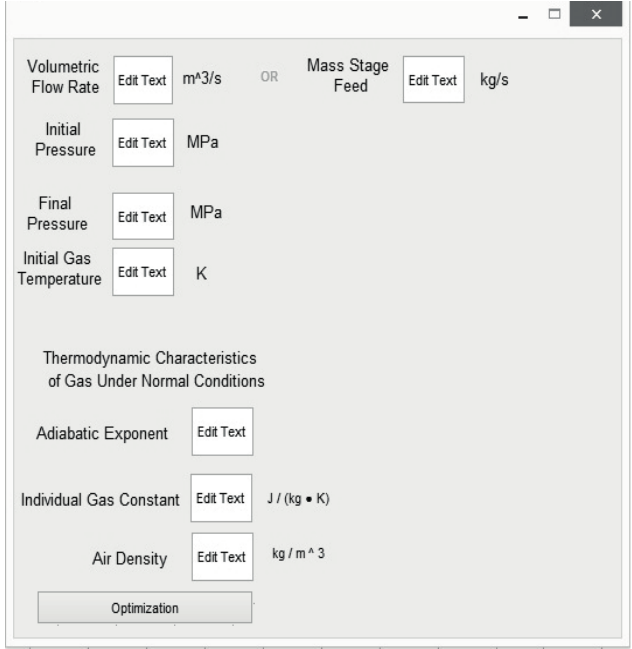
Fig. 3. The first window of the UI for entering the main parameters of centrifugal compressor.